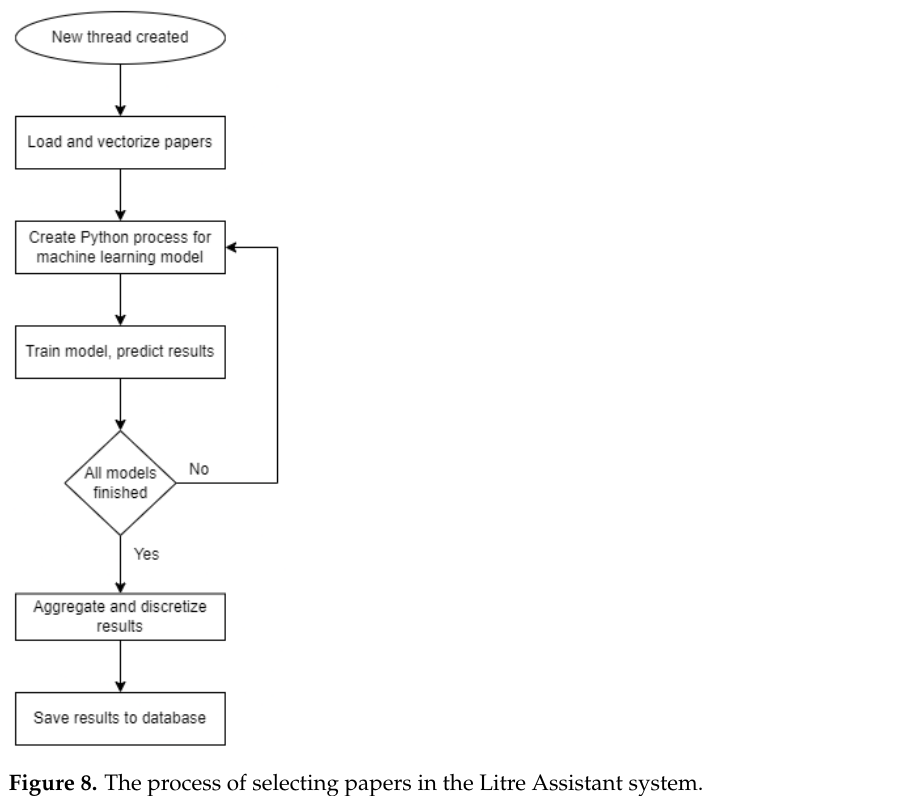
Figure 7. Abstract screening feature of the Litre Assistant system showing a list of papers (in the background) and a specific paper with more details to be marked.